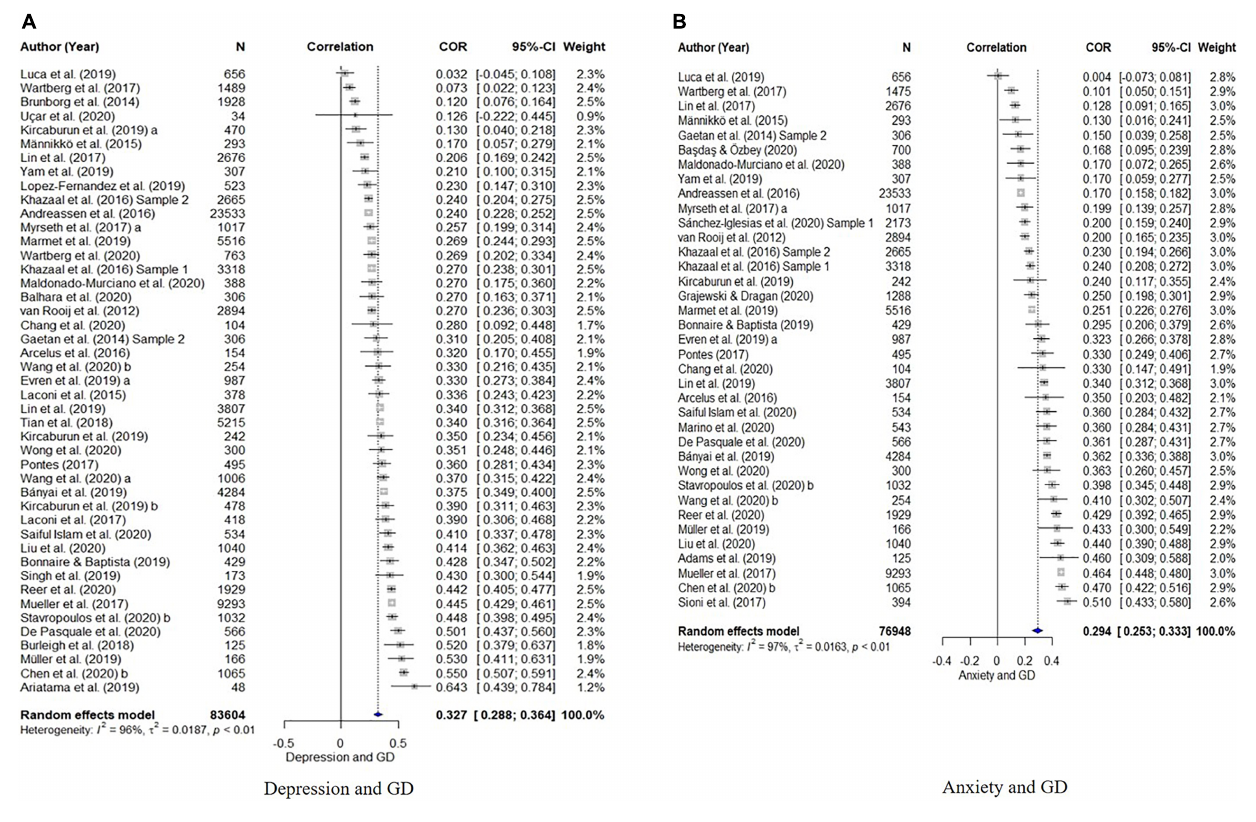
FIGURE 2 | Forest plots of correlations and 95% confidence interval (CI) for random effects meta-analysis model for (A) depression, and (B)